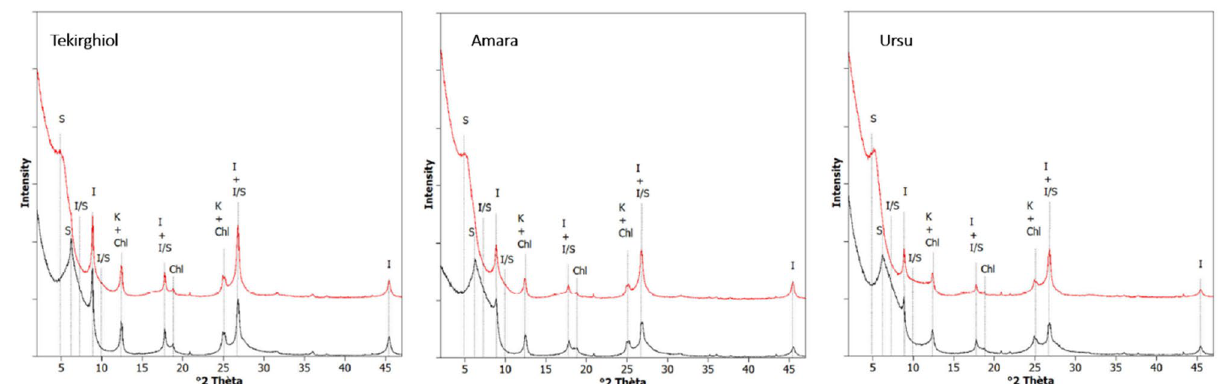
Figure 3. Diffraction patterns of air dried (red) and ethylene glycolated (black) oriented clay fractions in the three sapropels. The most important reflections are labeled: K—Kaolinite; I—Illite; I/S—Illite/Smectite; S— Smectite;